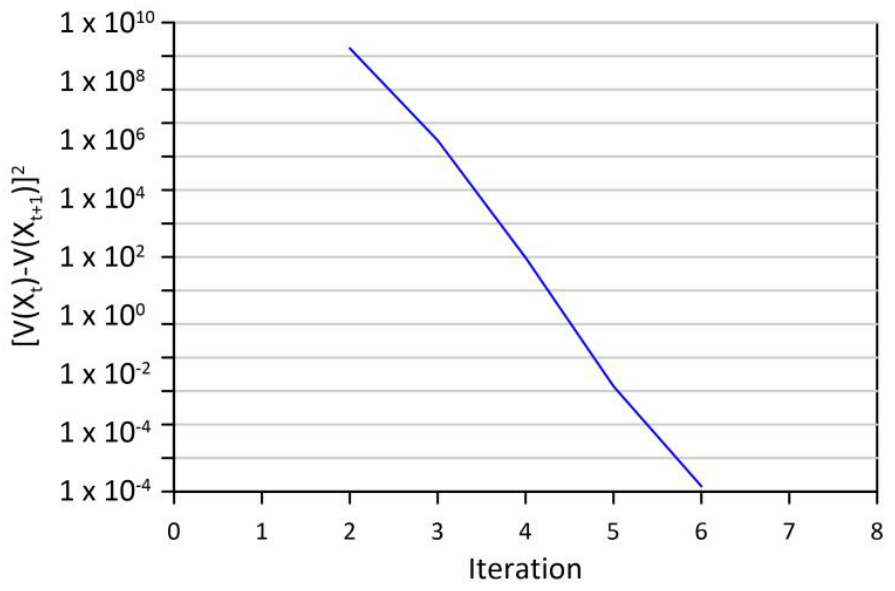
Figure 7. Trial 2: Iteration